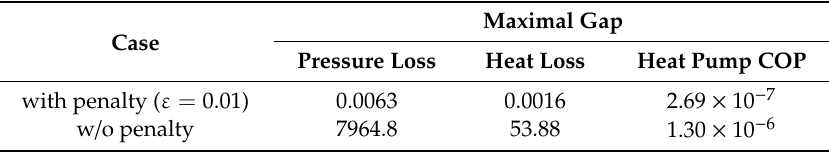
Table 2. Exactness of SOC constraints in our proposed